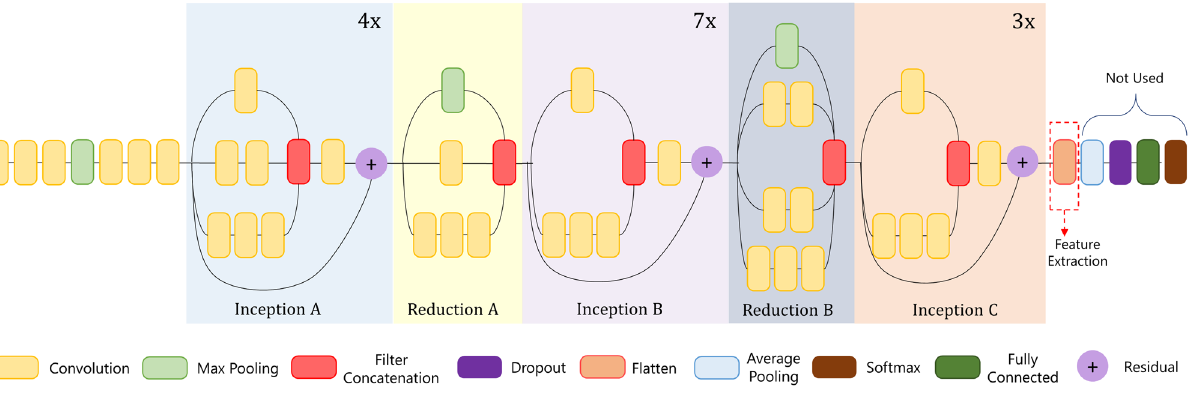
Figure 3. Architecture of the proposed CNN used in this